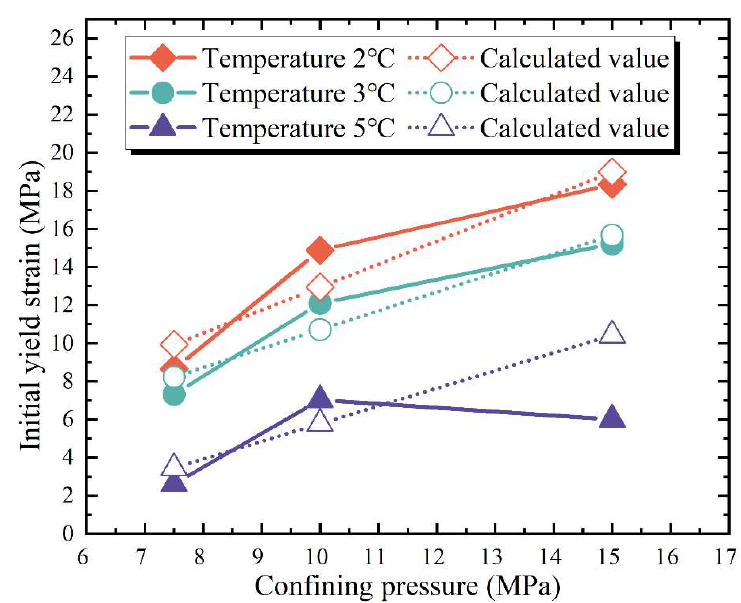
Figure 9. Fitting calculated value of initial yield strength q 0 .